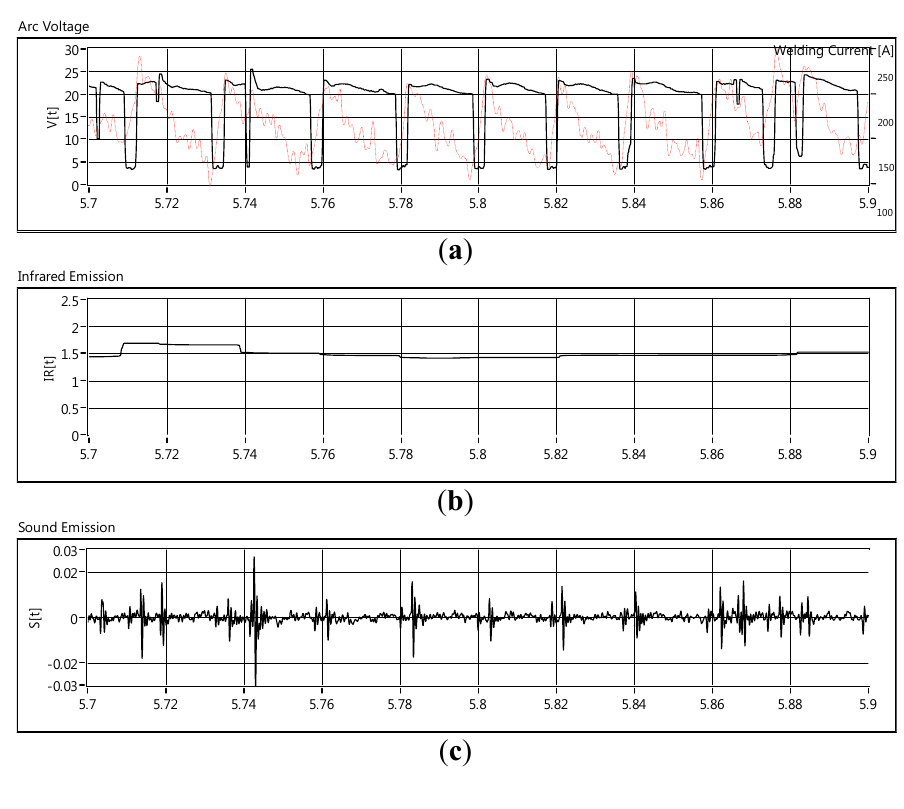
Figure 1. Welding arc parameters and